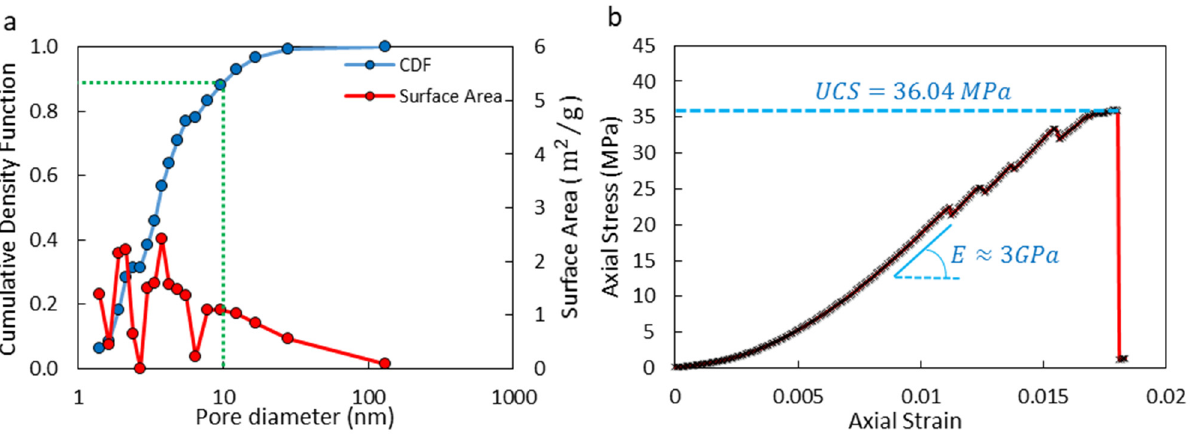
Figure 3. Measurements of ( a ) cumulative pore size distribution and specific pore surface area using BJH and BET techniques, respectively, and ( b ) the uniaxial compressive strength test results for the intact Calumet carbonate specimen.